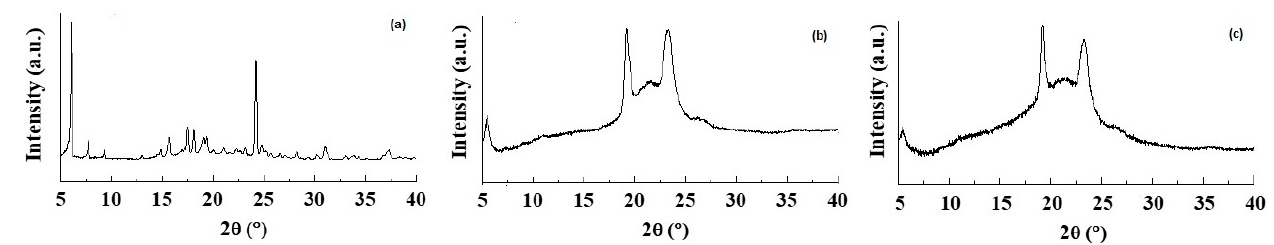
Figure 3. X-ray diffraction patterns of ( a ) pure CIT, ( b ) plain SLNs and ( c ) CIT-SLNs. The FT-IR spectra of the CIT-SLNs showed absorption bands occurring both in pure CIT and in the plain SLNs (Figure 2). Thus, the peak at 1737 cm − 1 , detectable in the FT-IR